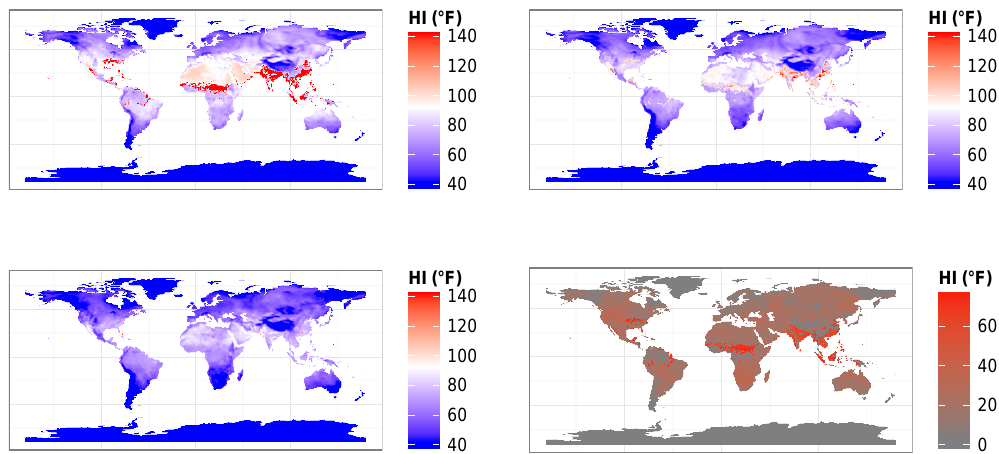
Figure 1. Typical heat index for an exemplary day (2 June 1996). Upper left: maximum heat index; lower left: minimum heat index; upper right: mean heat index; lower right: diel range of heat index.